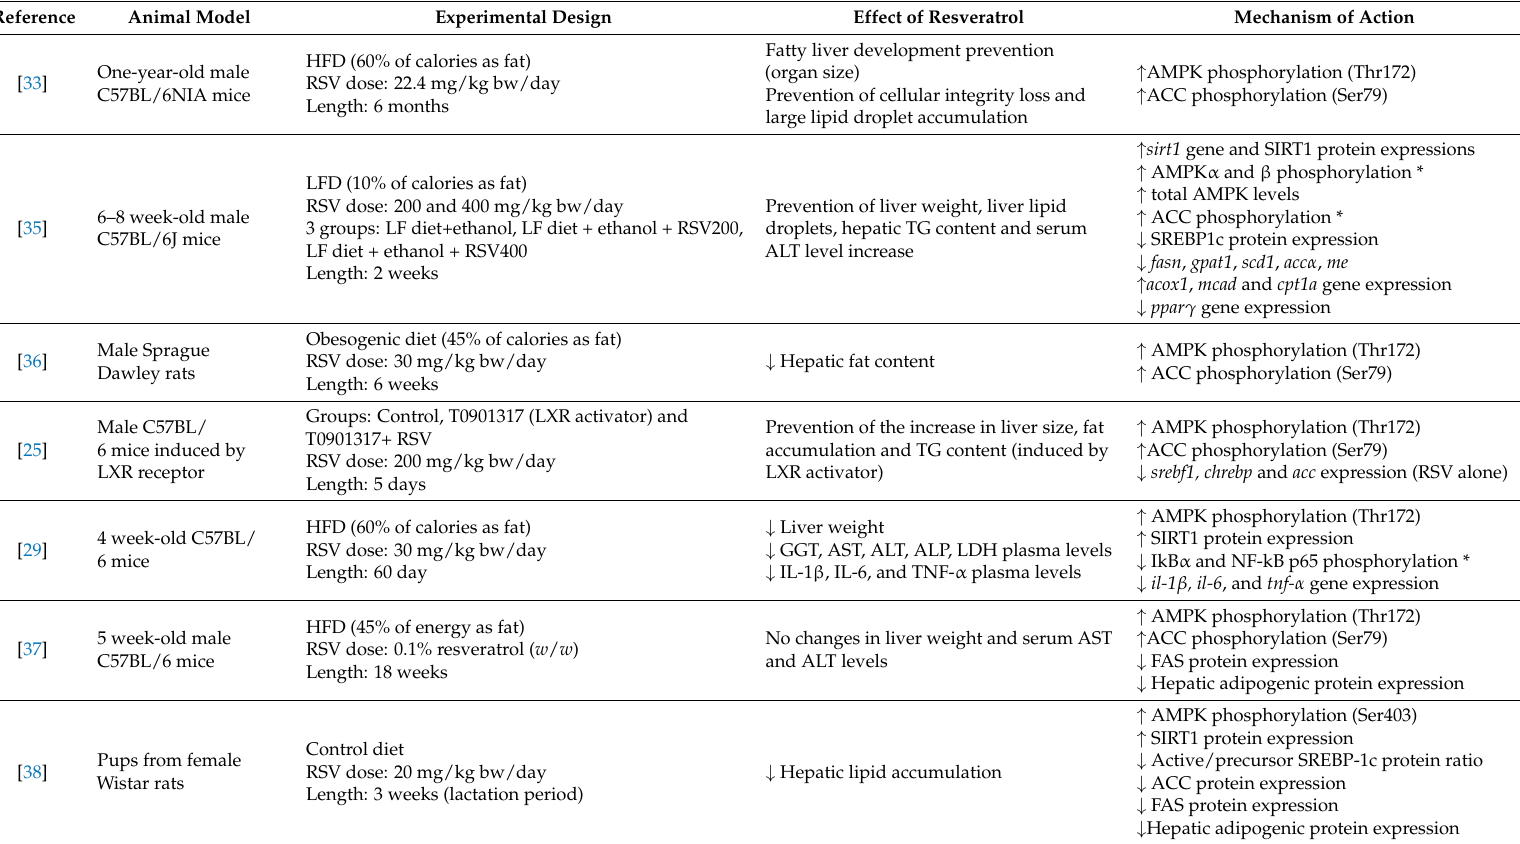
Table 2. Preclinical studies conducted in vivo to test the preventive effect of resveratrol on hepatic